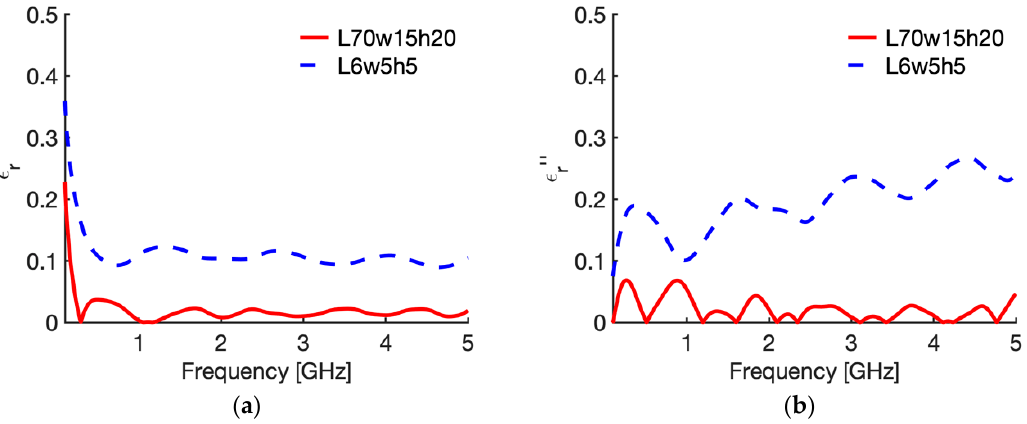
black line, 6; 5; 5; air).